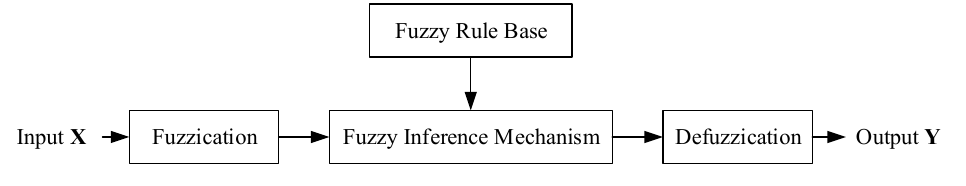
Figure 5. Overall flow of fuzzy inference system